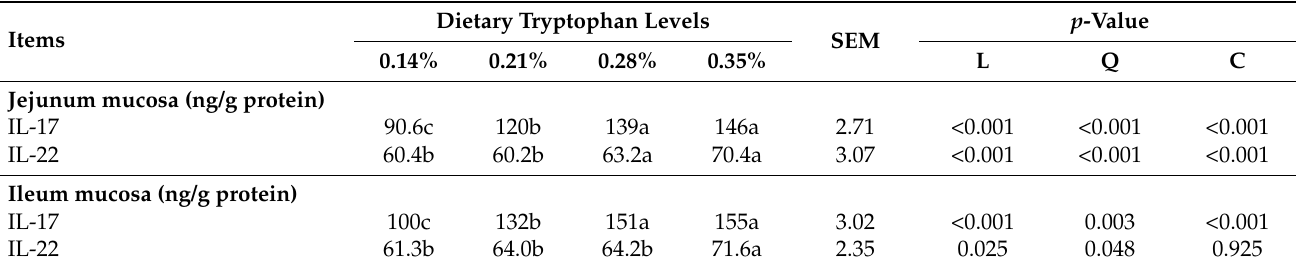
Table 6. Effect of dietary tryptophan levels on the concentrations of TNF- α , IL-17, and IL-22 in the jejunal and ileal mucosa of weaned